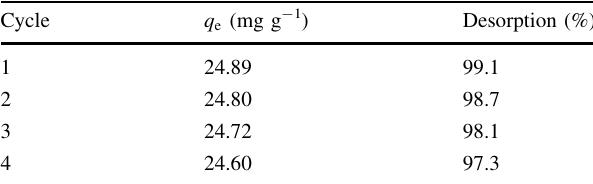
Table 4 The adsorption capacities and the desorption ratios of the DTC resin after different adsorption–desorption cycles Cycle q e (mg g - 1 ) Desorption